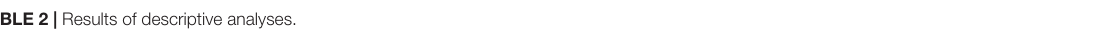
TABLE 2 | Results of descriptive analyses.